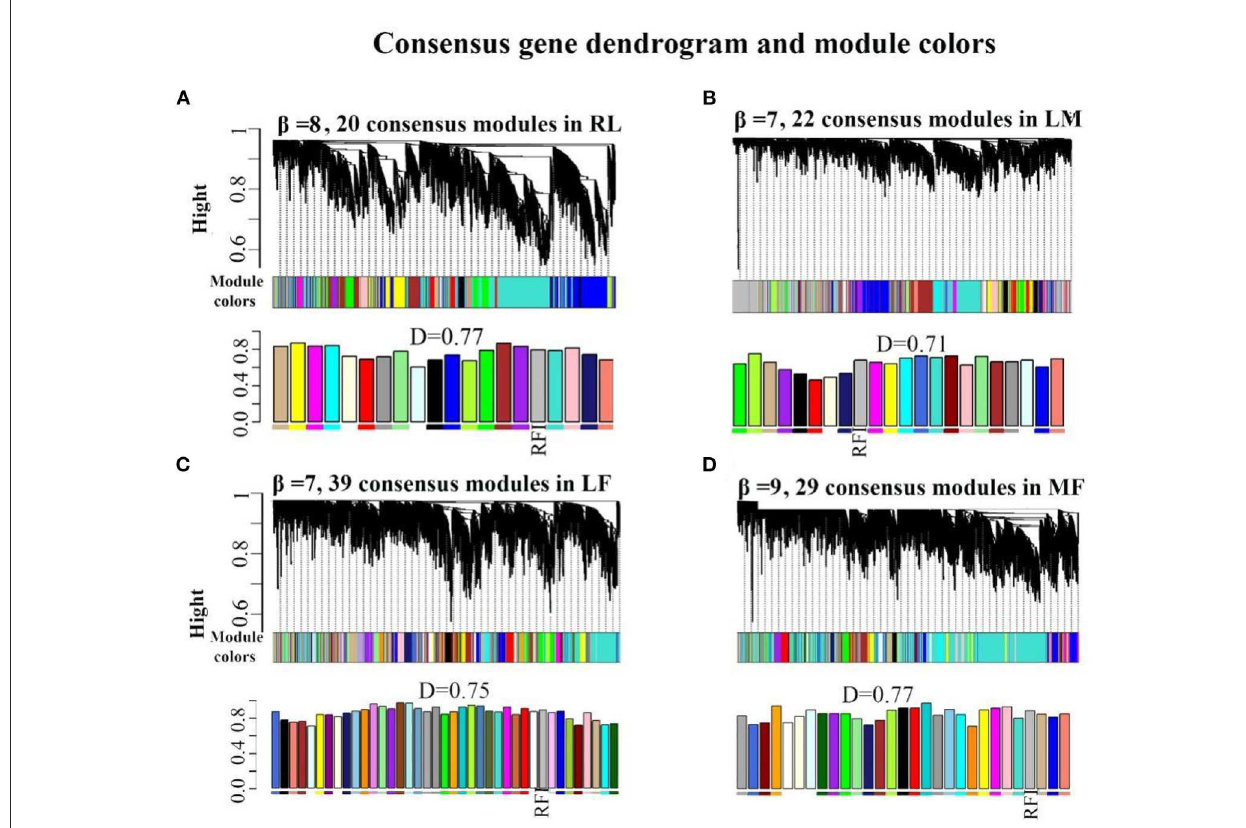
FIGURE1 Consensus module construction and detection. (A–D) was the consensus module construction for RL, LM, LF, and MF, and its power β , module amount and preservation were (8,7,7,9), (20,22,39,29) and (0.77, 0.71, 0.75, 0.77),